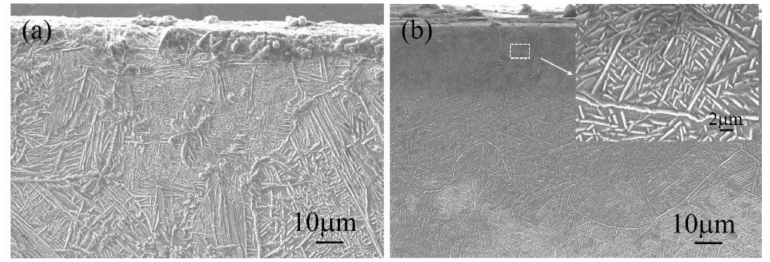
Figure 9. SEM image of the nitrided layer in di ff erent nitrogen–argon gas atmospheres: ( a ) 18% nitrogen and 82% argon, ( b ) 5% nitrogen and 95% argon.